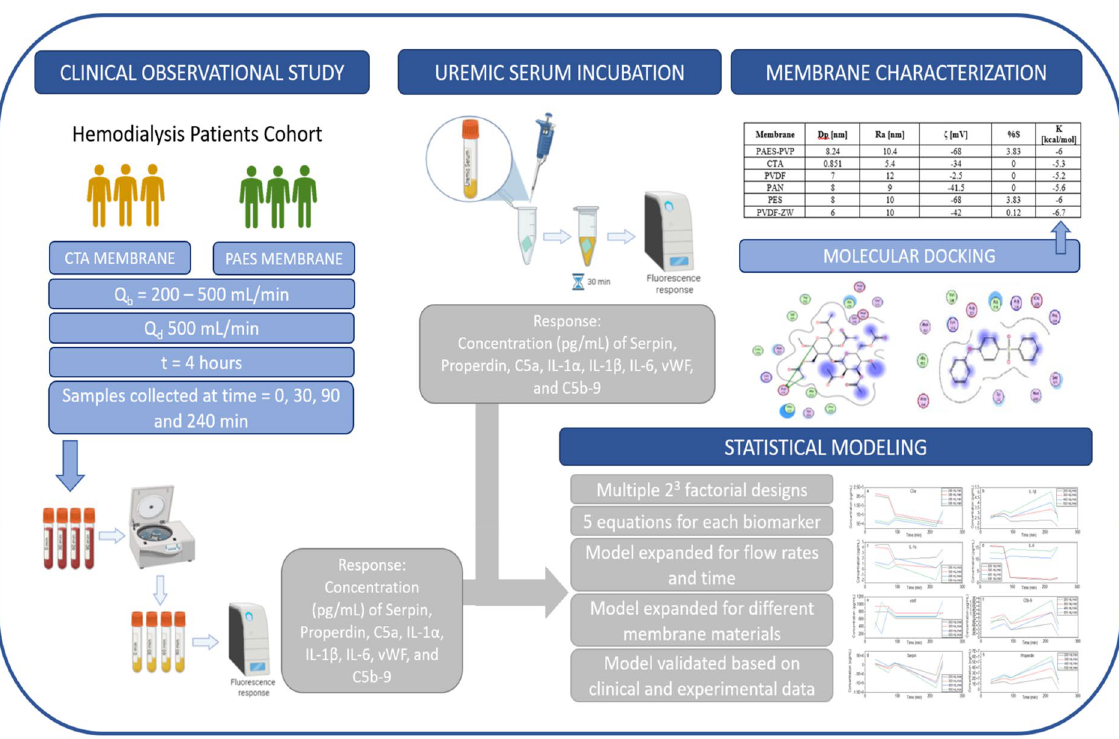
Figure 6. Summary of the modeling approach to predict the inflammatory biomarkers (BioRender